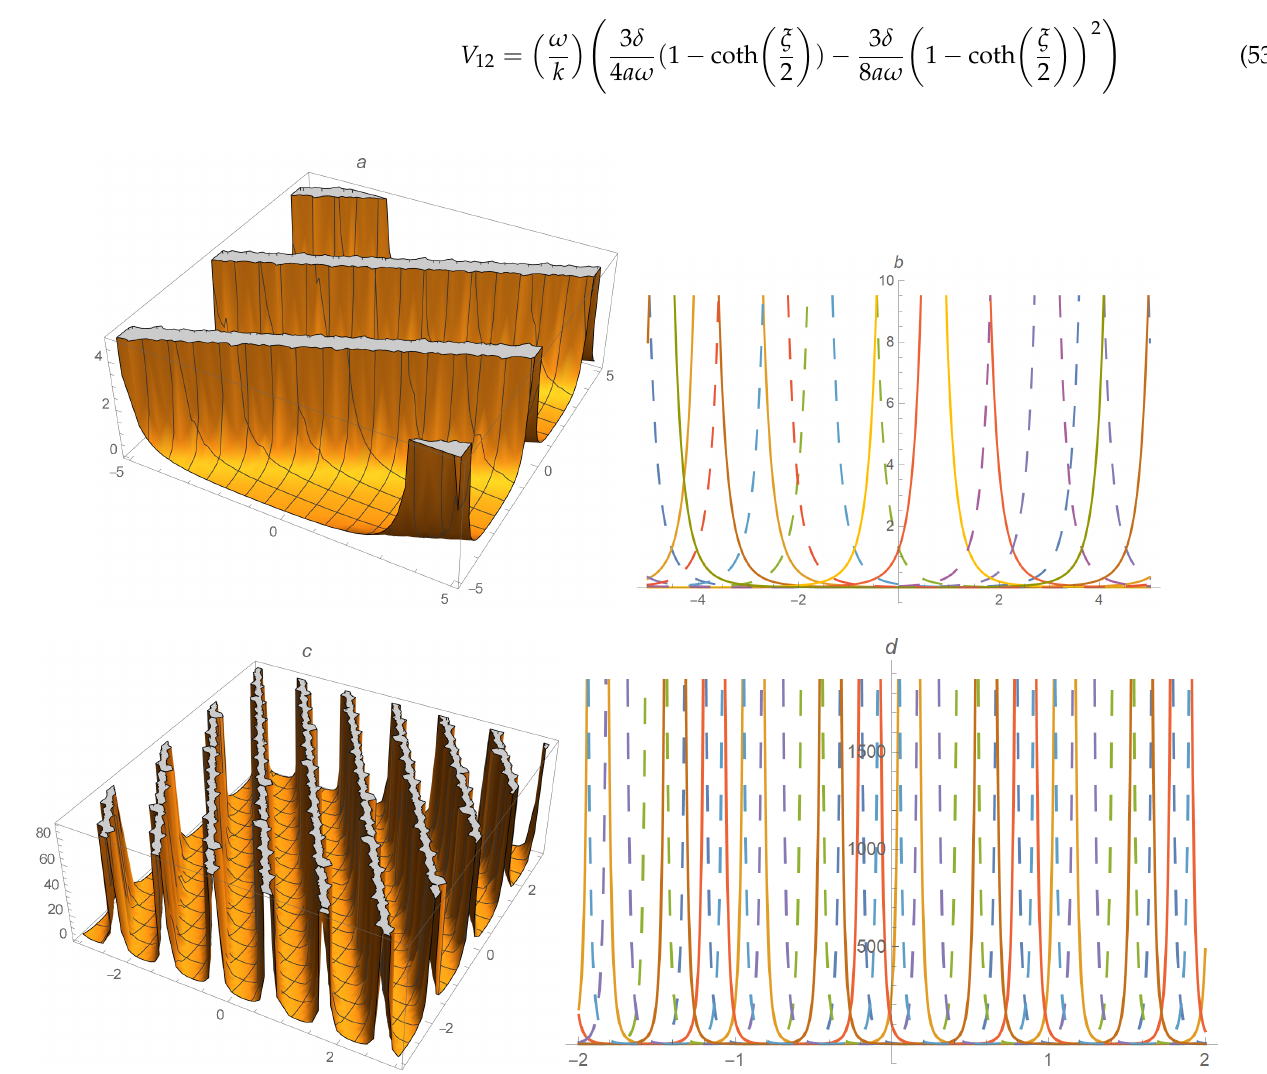
Figure 3. The profile of solutions U 9 ( a , b ) and V 9 ( c , d ) with c 2 = 1, c 0 = 3.2, α = 1, δ = 0.2, a = − 1, ω = − 0.5, ξ 0 = 0.5 and α = 1, c 2 = − 1, c 0 = − 0.2, δ = − 2.2, λ = 0.11, ω = − 0.5, ξ 0 = − 0.5